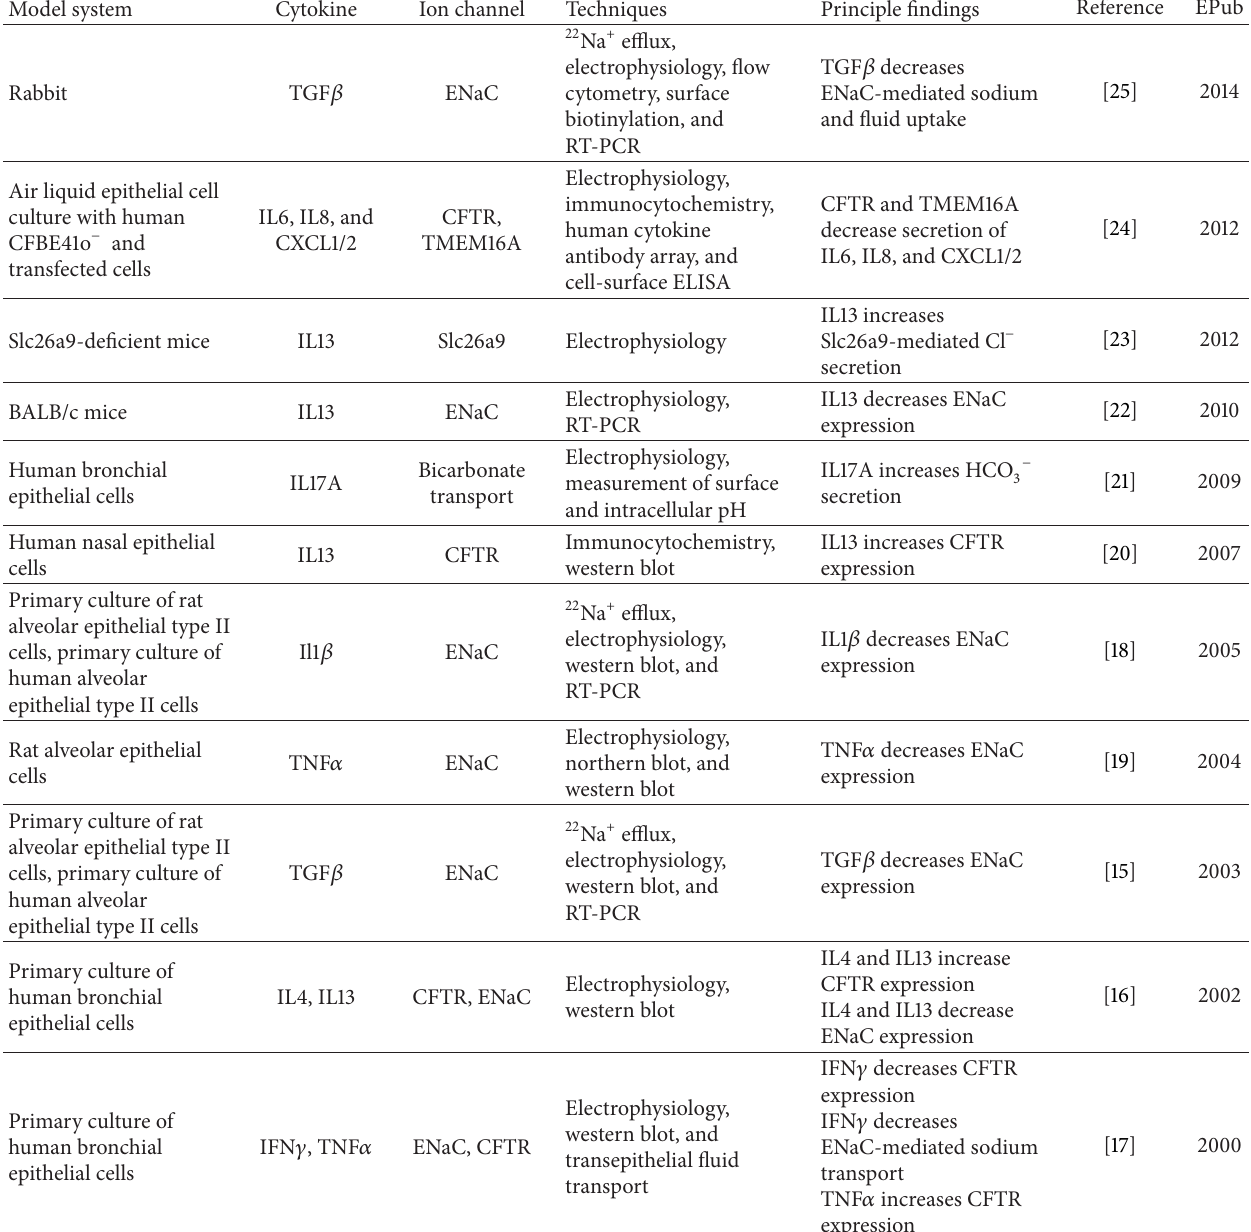
Table 1: Effect of cytokines on ion transport in airway epithelial